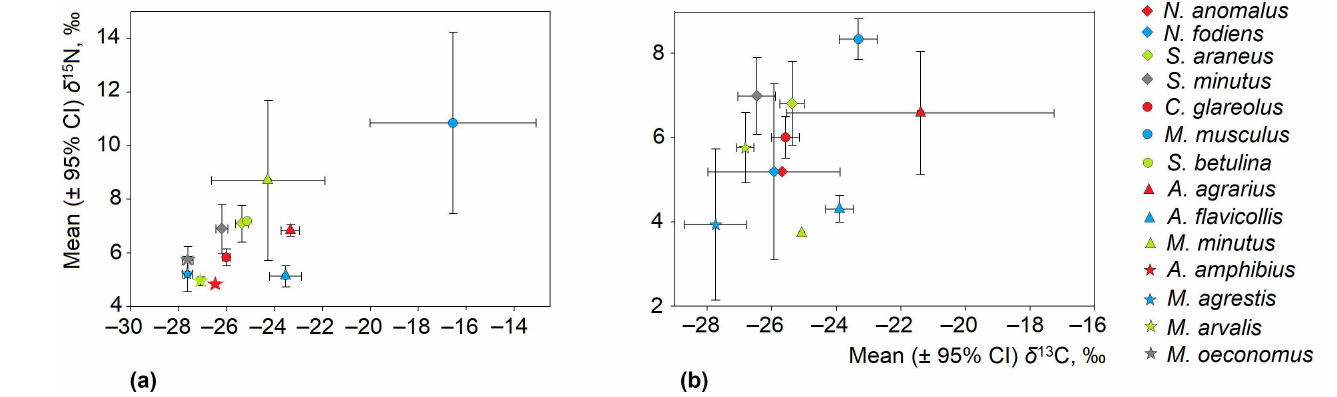
Figure 3. Isotopic position of Soricidae species in relation to other small mammal species based on stable isotope ratios in hair samples from commercial fruit and berry farms ( a ), and commensal habitats ( b ): (cid:52) —granivores, —omnivores, (cid:73) —herbivores, ♦ —insectivores. The rodent sample (cid:35) sizes in commercial orchards and commensal habitats were: C. glareolus 232/393, M. musculus 11/95, S. betulina 2/0, A. agrarius 430/213, A. flavicollis 540/322, M. minutus 18/1, A. amphibius 1/0 , M. agrestis 42/20, M. arvalis 556/109, and M. oeconomus 46/14 individuals,